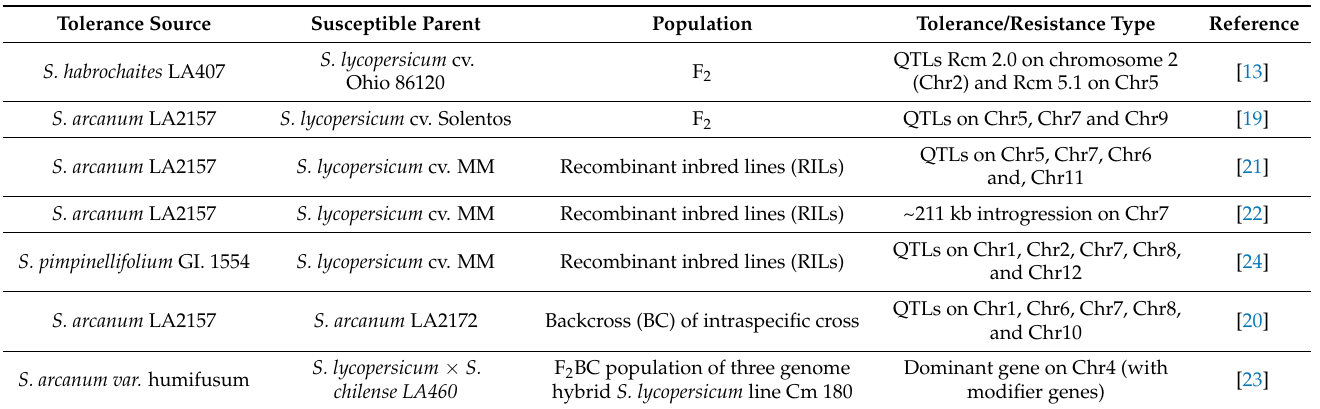
Table 1. Overview of loci associated with tolerance to Cm derived from wild